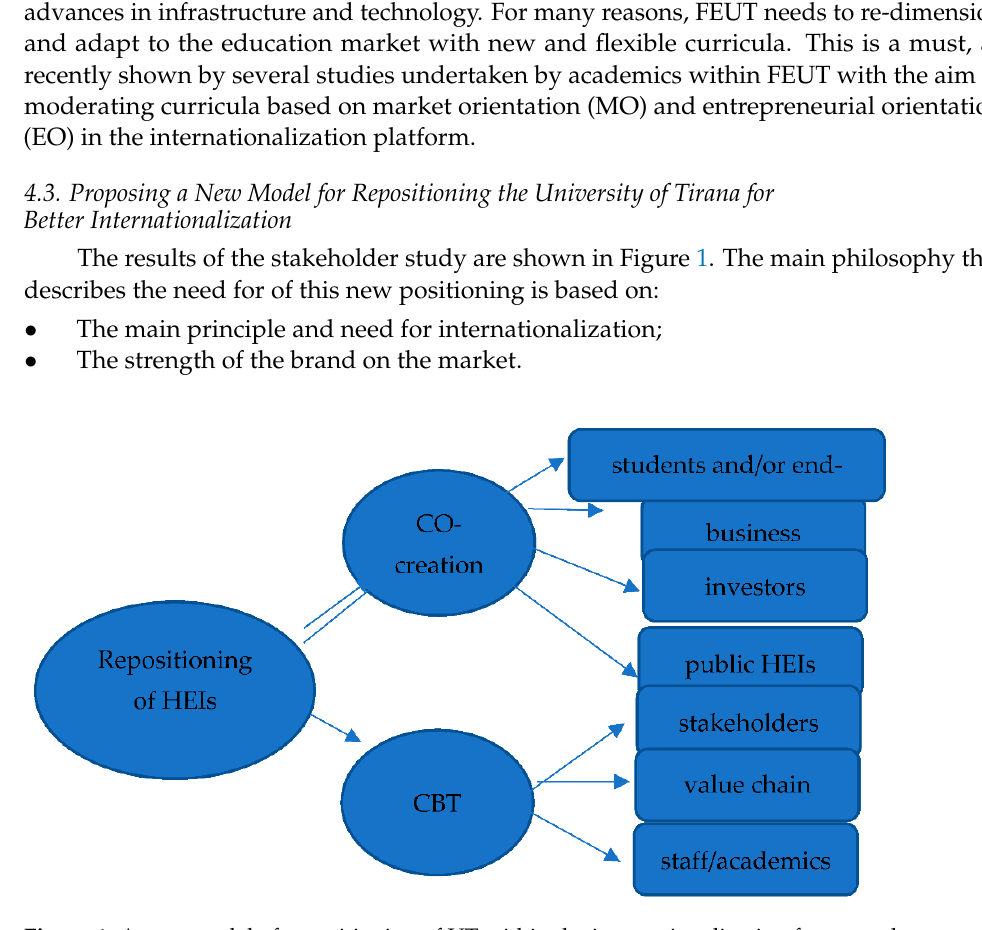
Figure 1. A new model of repositioning of UT within the internationalization framework .